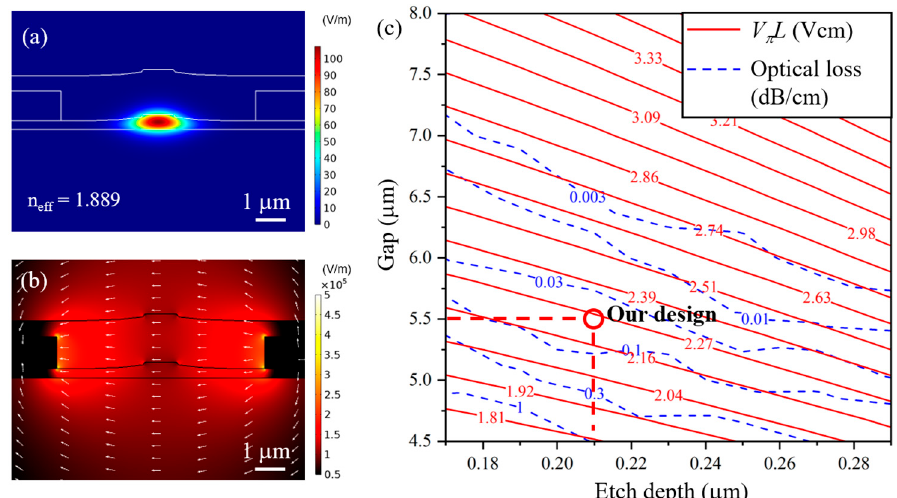
Figure 1. ( a ) Simulated optical field profile of the fundamental transverse electric (TE) mode in the lithium niobate (LN) ridge waveguide. ( b ) Simulated static electric field when applying a 1 V voltage between the electrodes. ( c ) Contour map of both V π L and optical loss versus different gaps and etching depths.